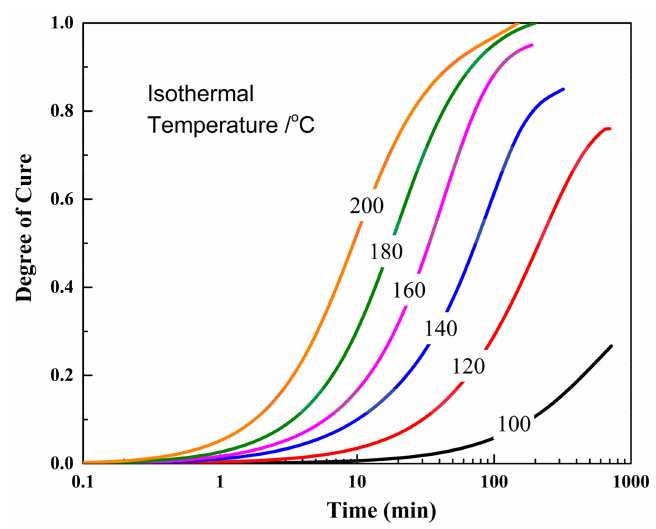
Figure 3. Degree of cure evolution at various isothermal temperatures.